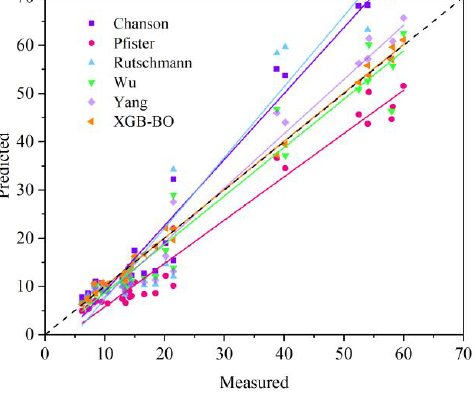
Figure 5. Cavity depth prediction derived from empirical correlations and XGBOOST-BO.